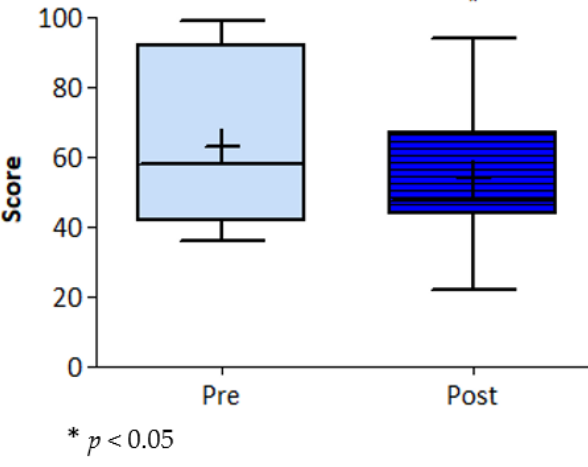
Figure 1. Exercise self-efficacy score.